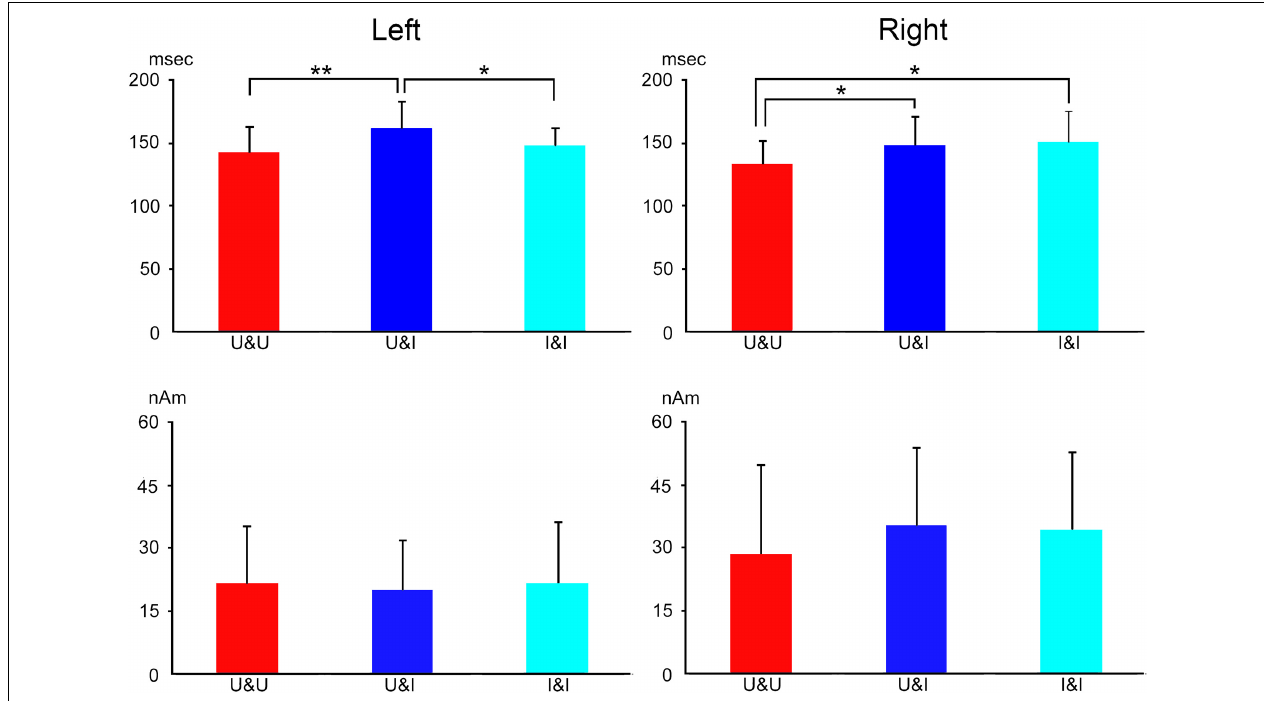
FIGURE 7 | Bar graph of peak latency (upper) and the maximum amplitude of dipole moment (lower) for all conditions after stimulus onset in the right and left hemispheres. Error bar shows the SD [adopted from Miki et al. (2011)]. ∗ p < 0.05 and ∗∗ p < 0.01. SD, standard